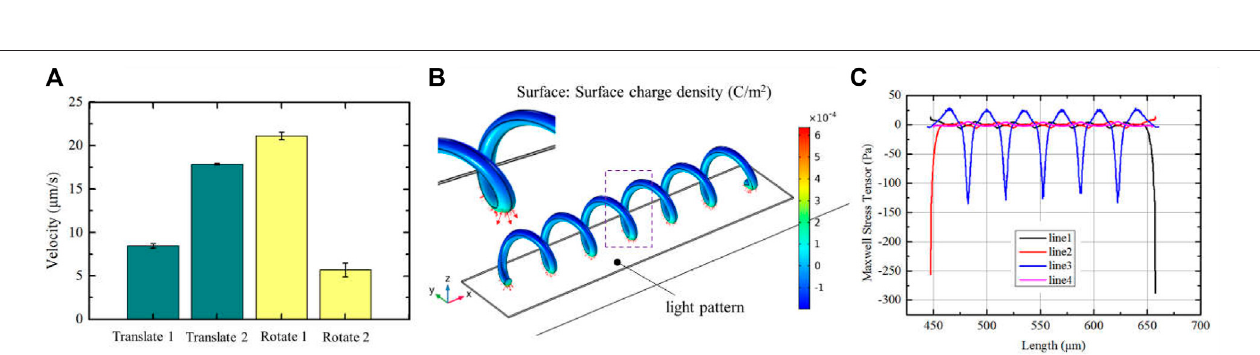
FIGURE7|(A) Manipulationvelocityofthedifferentmanipulationmodes;simulationresultsof (B) surfacechargedensityand (C) Maxwellstresstensordistribution when the light pattern with a little bit bigger than the length of micro-spiral.